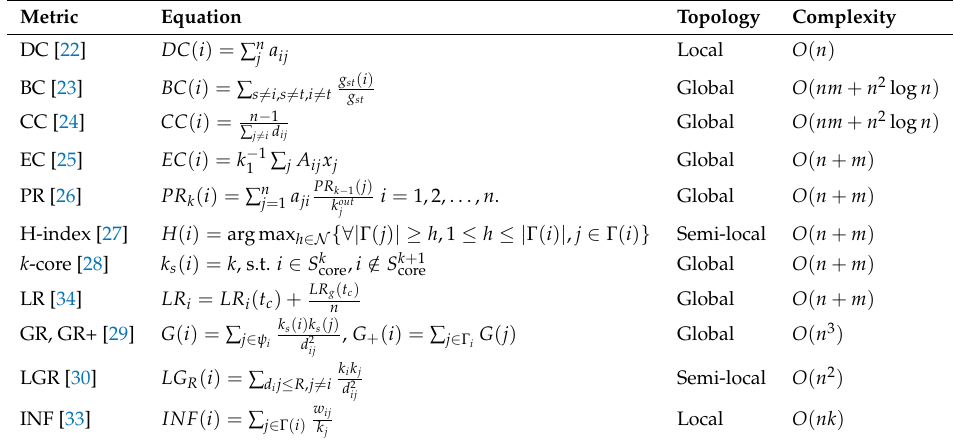
Table 1. A brief comparison of node centrality